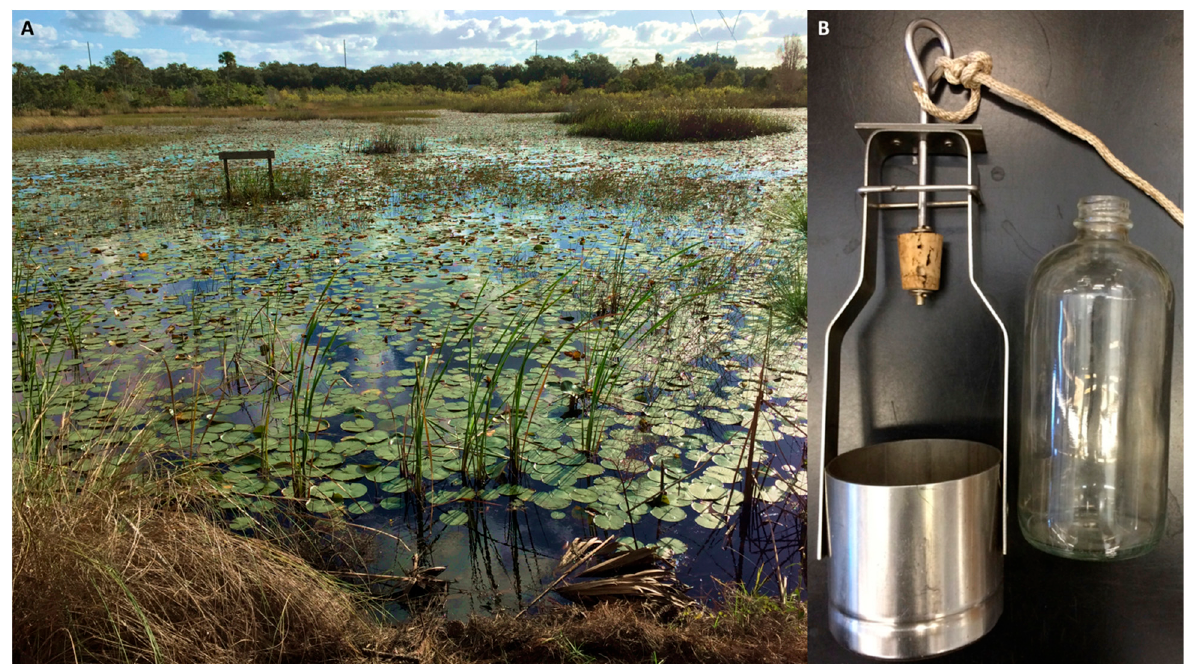
Figure 1. Florida sampling location and collection device. ( A ) Indrio Savannahs Preserve. This was the main sampling location investigated and the Florida habitat of Pseudoblepharisma . ( B ) Caged sampler with 500 mL bottle. This collecting apparatus was used for filling 500 mL sample bottles from all sites investigated. The weighted cage opens to allow the loading of a new bottle. The cork on a line mechanism allowed for it to be pulled within the site, obtaining a sample at the desired depth.